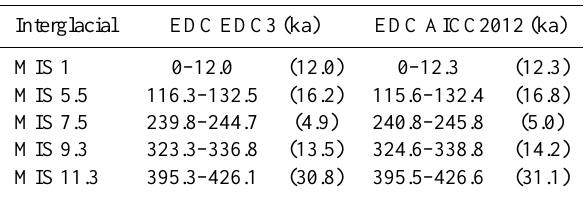
Table 6. Comparison of the warm interglacial durations at EDC on the AICC2012 and EDC3 age